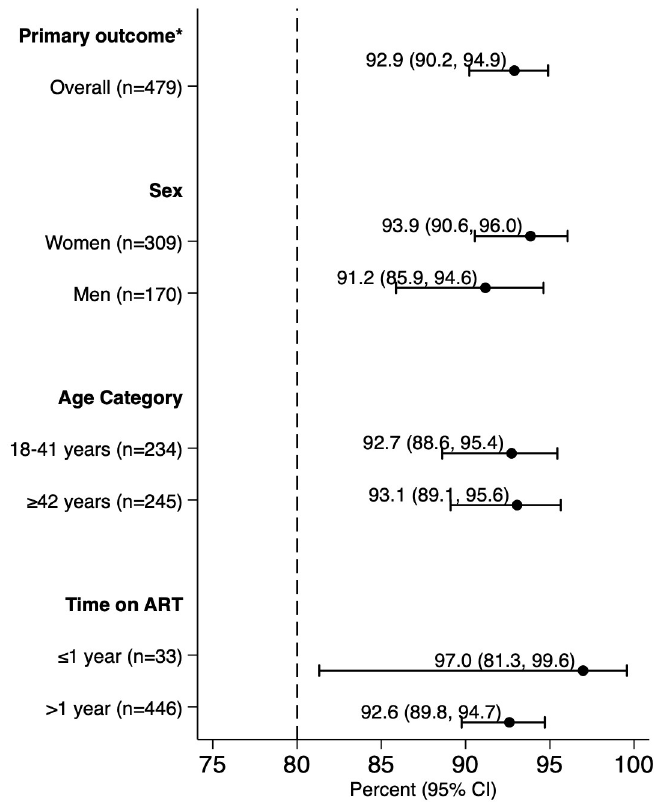
Fig 2. 3HP acceptance and completion, by subgroup. The forest plot shows the proportion and 95% CIs of participants accepting and competing 3HP treatment (took at least 11 of 12 doses of 3HP within 16 weeks of randomization) overall and by sex, age, and time on ART. ART, antiretroviral therapy; CI, confidence interval. � Accepting and completing treatment ( � 11 of 12 doses within 16